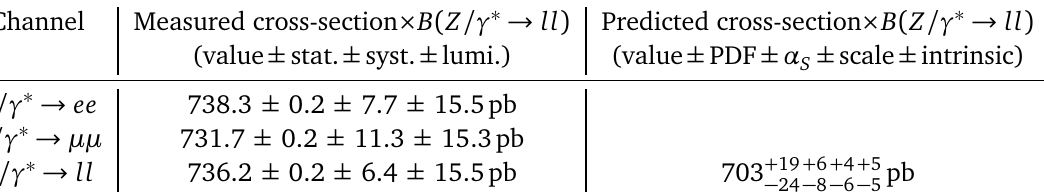
Table 3: Measured integrated fiducial cross section in electron and muon decay chan- nels at Born level as well as the combination (from [ 3 ] ). The prediction at NNLO in α uses the CT14 PDF set. S